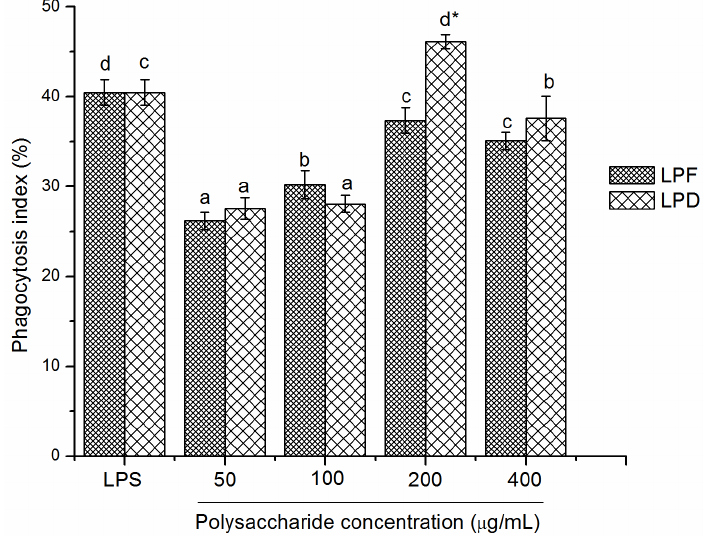
Figure 5. Effects of the litchi polysaccharides LPF and LPD on the phagocytosis of RAW264.7 macrophages. Their phagocytosis indexes were evaluated by measuring the phagocytosis against neutral red and expressed as the mean ± standard deviation ( n = 6). Bars labeled with different letters represent a statistical difference at p < 0.05 among different concentrations of the same sample. ( * ) 0.01 < p < 0.05 and ( ** ) p < 0.01 compared with